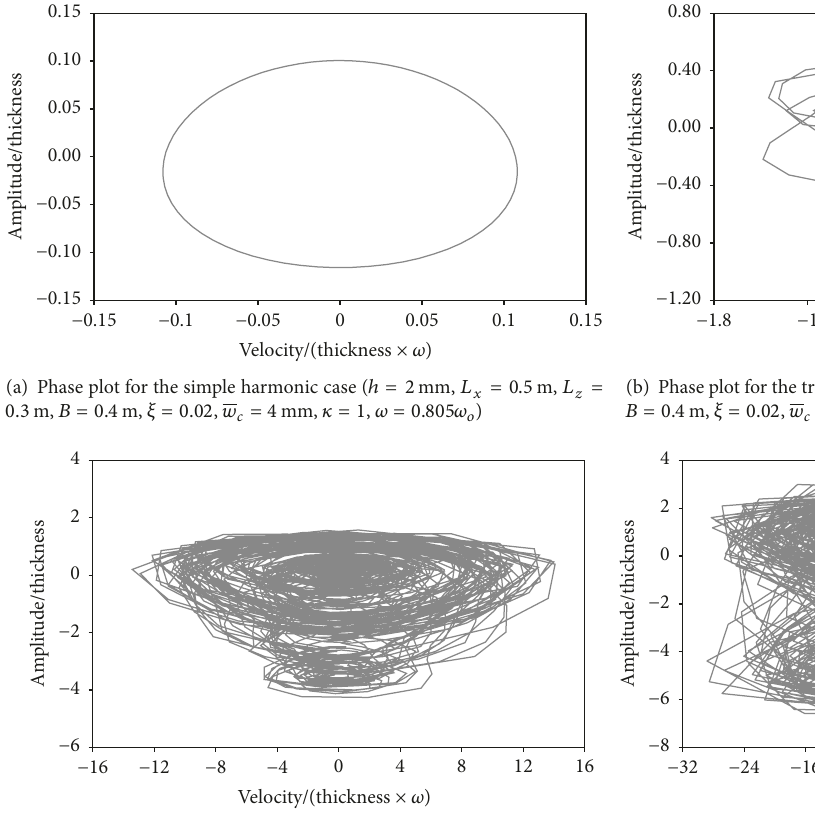
(c) Phase plot for the chaotic case ( ℎ = 2 mm, 𝐿 𝑥 = 0.5 m, 𝐿 𝑧 = 0.3 m, 𝐵 = 0.4 m, 𝜉 = 0.02 , 𝑤 𝑐 = 4 mm, 𝜅 = 4.5 , 𝜔 = 0.805𝜔 𝑜 )